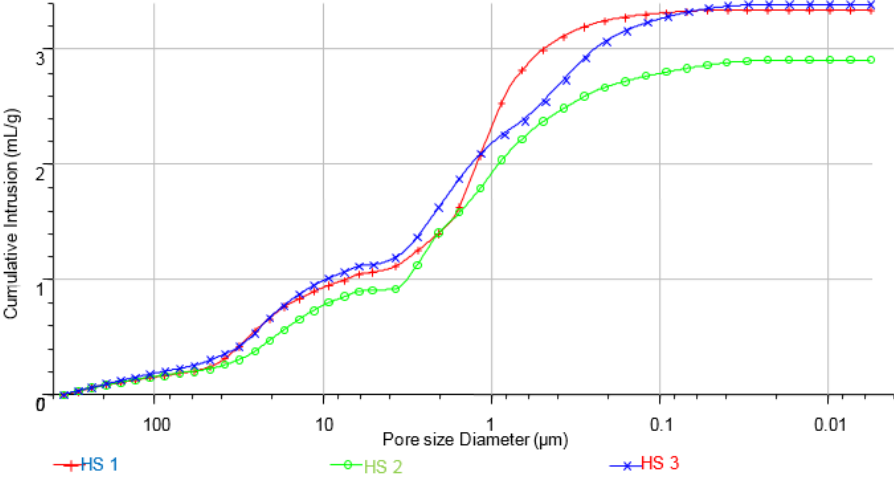
Figure 4. Cumulative intrusion vs. pore size diameter ( μ m).